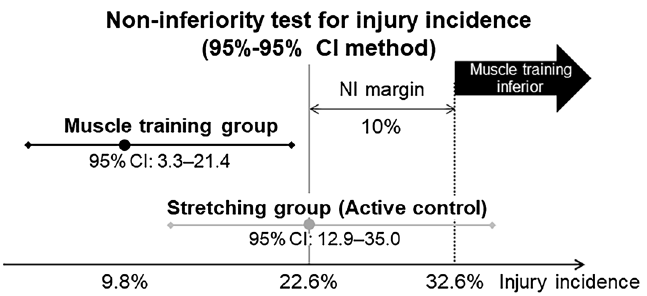
Figure 2. Non-inferiority test for injury rate. Injury rates in the muscle-training and stretching groups were 9.8% (95% confidence interval [CI] 3.3–21.4) and 22.6% (95% CI 12.9–35.0), respectively. The non-inferiority (NI) margin was 10%. The muscle-training group had a significantly lower injury rate than the stretching group with a pre-specified NI margin ( P <